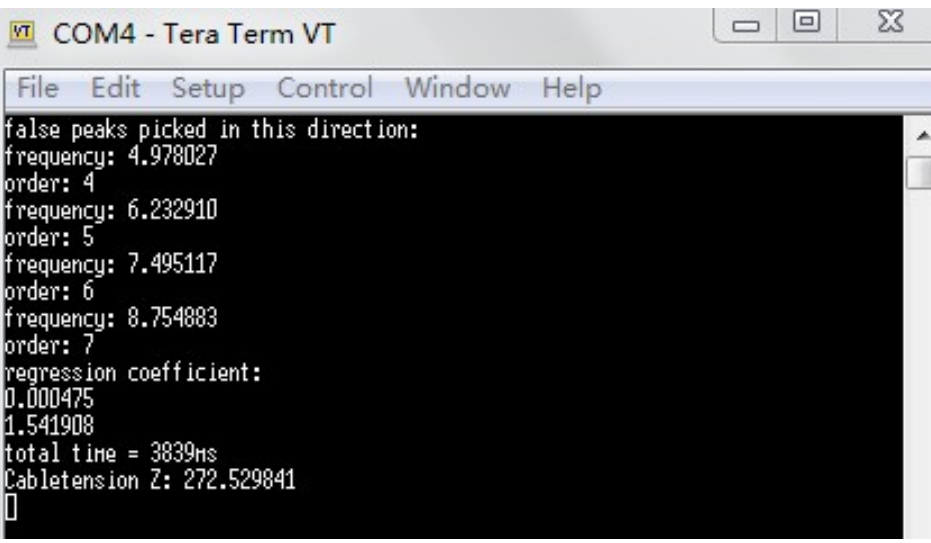
Figure 13. Cable tension estimation results from Xnode.